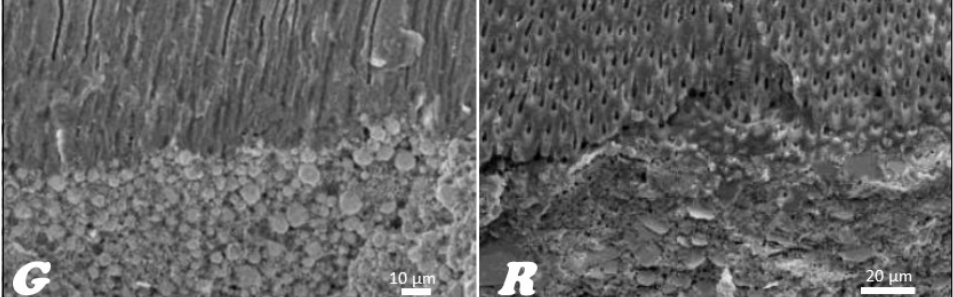
Figure 19. Tight connection as a result of cold lateral condensation of the root dentin with the filling material covered with an intermediate layer of sealant with a visible cross ‐ section of the dentinal tubules; material based on gutta ‐ percha with visible dental tubules along their axis transverse to the root canal ( G ); resilon with a visible cross ‐ section of the tooth tubules transverse to their axis, transverse to the axis of the root canal with a thin intermediate layer of sealant ( R ); SEM.